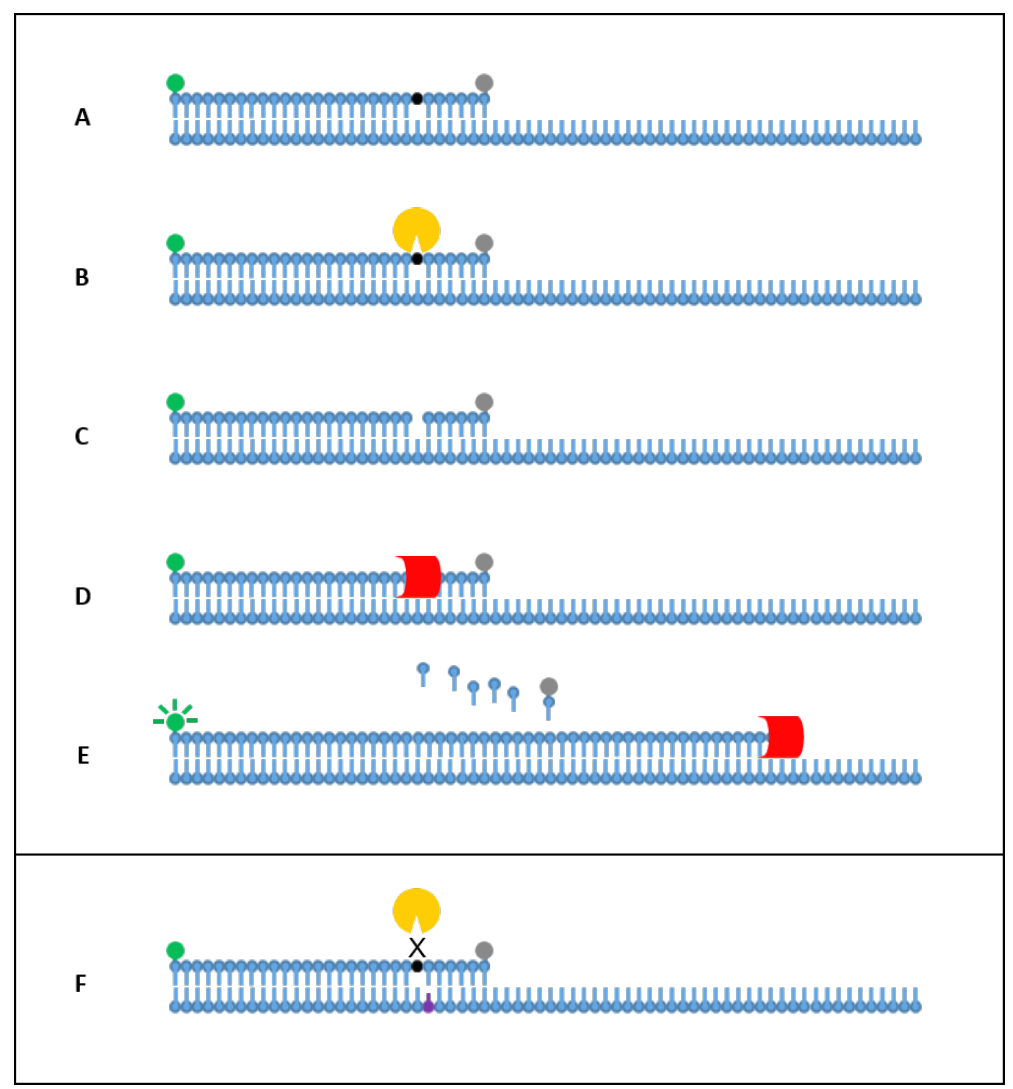
Figure 1. 3TEC-PCR detection mechanism. ( A ) The 3TEC-PCR primer/probe, containing a 5 (cid:48) fluorophore (green), an internal abasic site (black), and a 3 (cid:48) quencher (grey), hybridises to its complementary target during PCR annealing. The quencher, coordinated to the 3 (cid:48) -end hydroxyl group, absorbs fluorophore signal and prevents DNA polymerisation. ( B ) After target hybridisation, the abasic site (black) is in duplex form leading to Tth endonuclease IV (yellow) cleavage of the phosphodiester bond. ( C ) Cleavage of the abasic site leaves a single nucleotide gap with a free 3’ hydroxyl group. ( D ) DNA polymerase (red) coordinates to the free hydroxyl group, initiating strand extension. ( E ) Exonuclease activity of the polymerase enzyme dissociates nucleotides downstream of the abasic site, leading to fluorescence production from fluorophore and quencher separation. ( F ) Presence of a single-nucleotide polymorphism (purple) on the 3 (cid:48) -side of the abasic site prevents complete duplex structure formation, thus inhibiting cleavage and preventing fluorescence